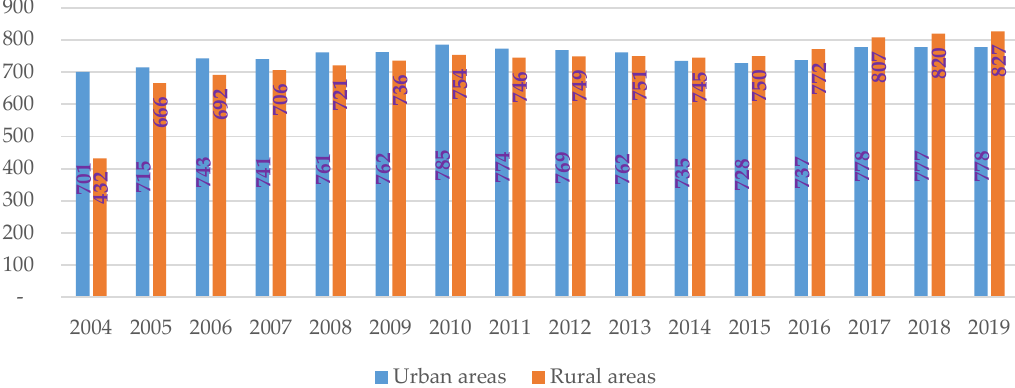
Figure 6. Unit electricity consumption in Poland (kWh/per capita). Source: authors’ calculations based on Local Data Bank [44].